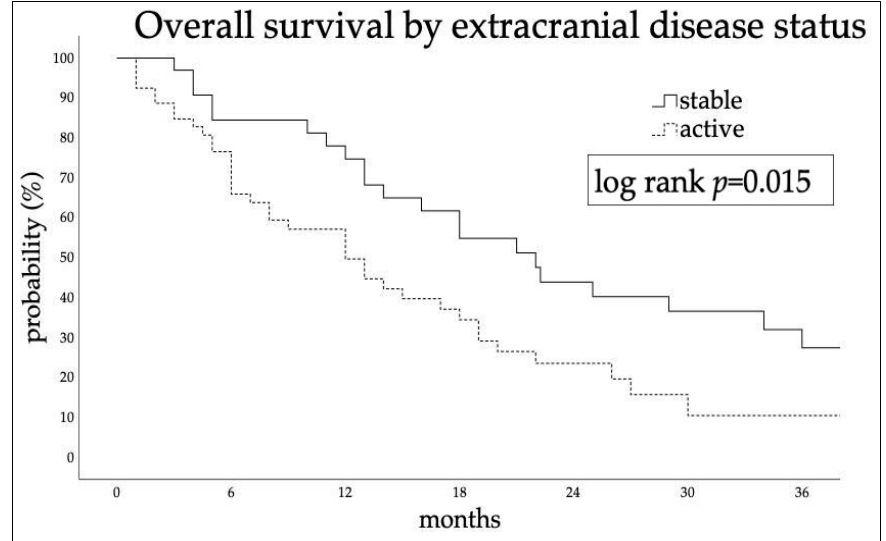
Figure 2. Kaplan–Meier estimated time-to-event curves by extracranial disease status at time of SRT.